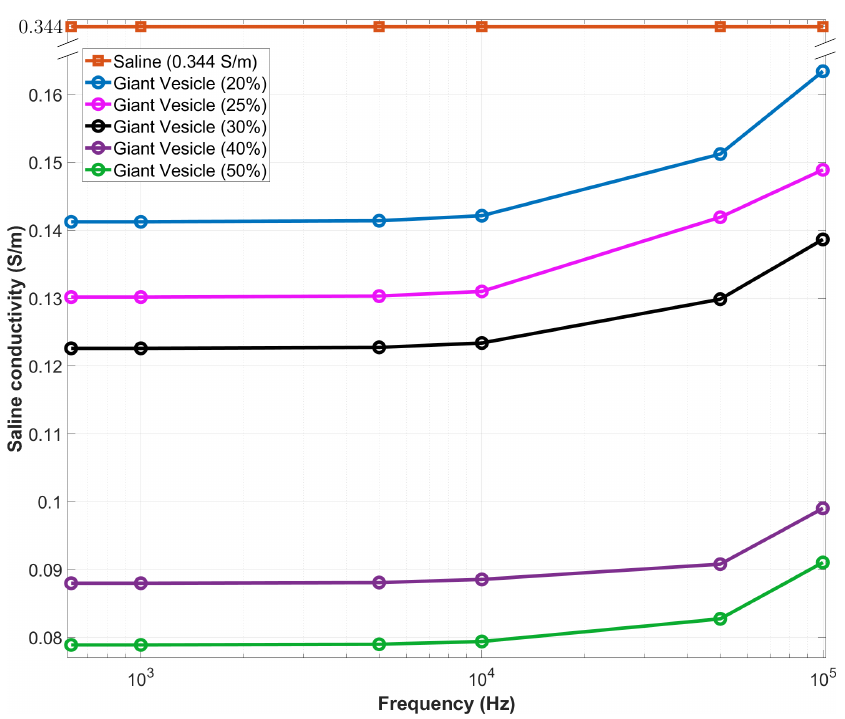
Figure 6. Conductivity spectra of giant vesicle suspensions in saline when applied frequencies are 0.625, 1, 5, 10, 50, and 100 kHz. Five different partial volume fractions of 20%, 25%, 30%, 40%, and 50% giant vesicles in the saline with the same amount of total volume are marked as circles in the conductivity spectra. The saline conductivity spectrum is displayed as